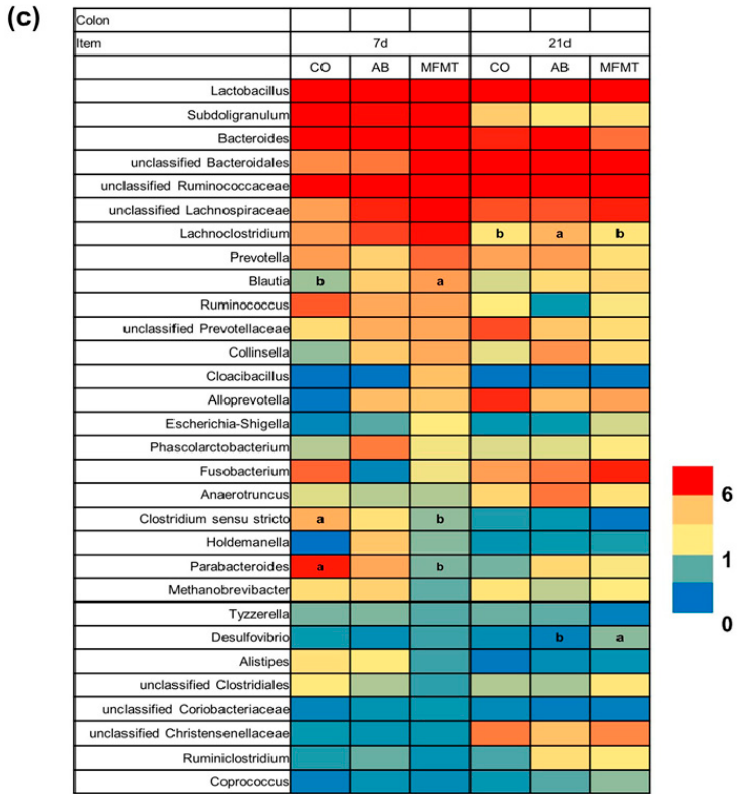
Figure 2. Relative abundances of the microbial genus in the stomach ( a ), ileum ( b ), and colon ( c ) of piglets in the maternal fecal microbiota transplantation (MFMT), amoxicillin (AM), and control (CO) groups. Mean values within a line with different superscript letters (a, b) on each day differ significantly ( p < 0.05).